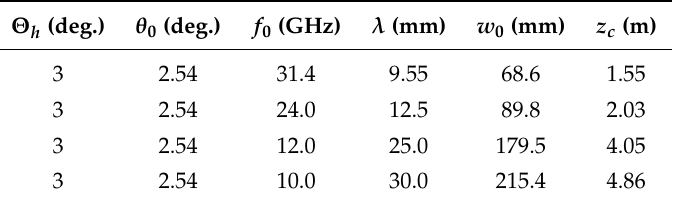
Table 2. Gaussian optics parameters.